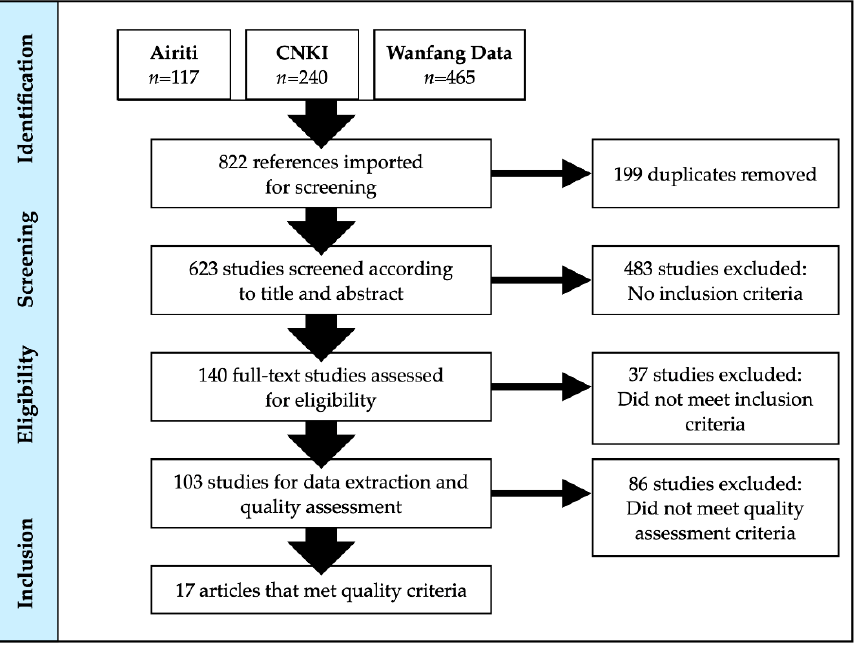
Figure 2. PRISMA diagram of Chinese-language literature search results.